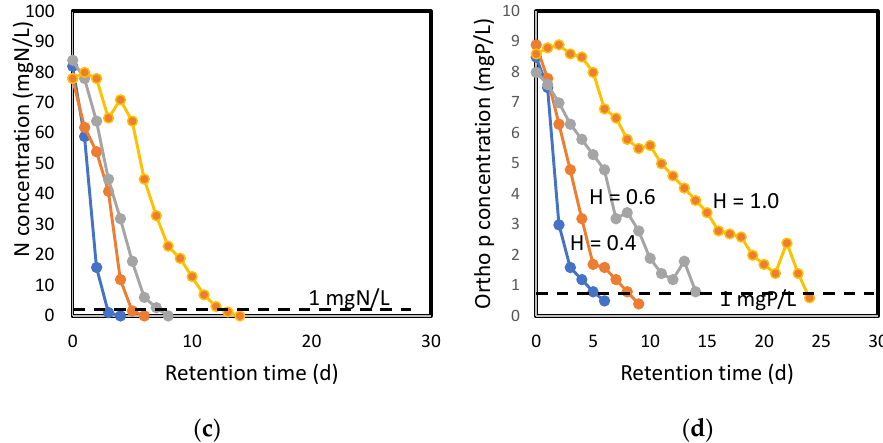
Figure 3. ( a ): Average values of DO concentrations as functions of time in SBPP with different depths H (0.2 to 1.0 m), ( b ): Average pH values as functions of time in SBPP with different depths H (0.2 to 1.0 m), ( c ): Average values of ammonium concentrations as functions of time in SBPP with different depths H (0.2 to 1.0 m), ( d ): Average values of phosphate concentrations as functions of time in SBPP with different depths H (0.2 to 1.0 m).